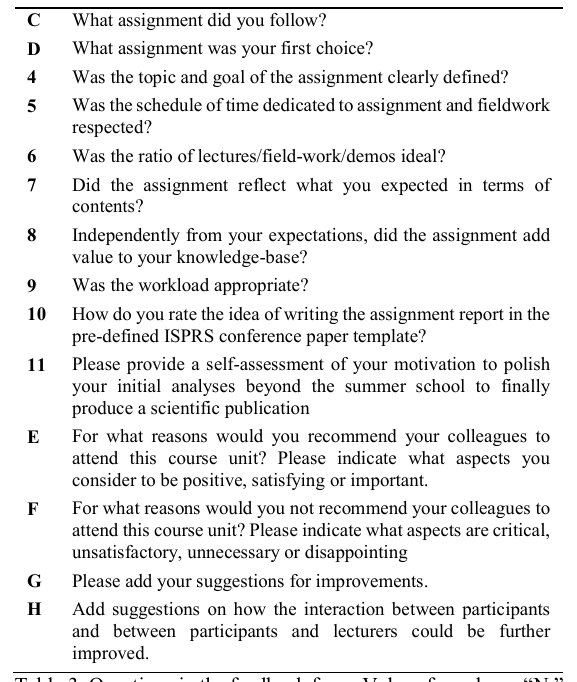
Table 3. Questions in the feedback form. Values for column “N.” are enumerated (1-11) for ordinal scale answers, or letters (A-D) for nominal scale and remaining (E-H) for free text answers 3.2.1